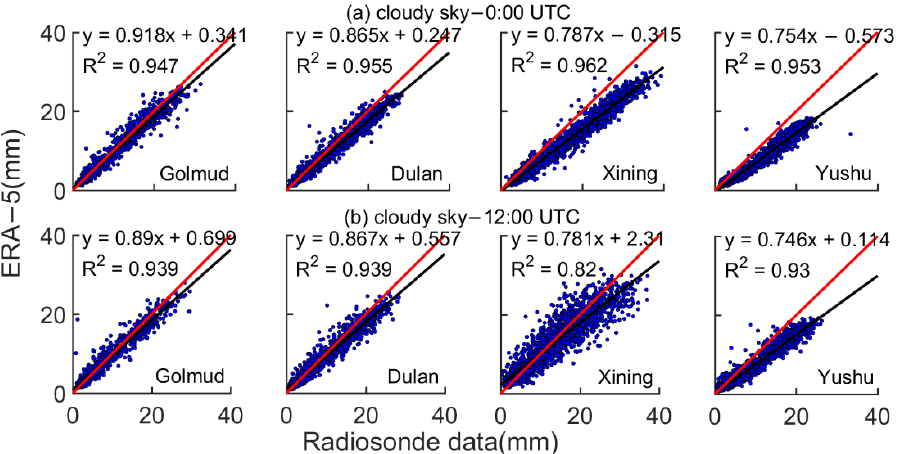
Figure A3. Scattered relationship of PWV from ERA-5 and radiosonde data under cloudy conditions at different meteor- ological stations. Black solid line is for linear fit, and red solid line is y = x. ( a ) 0:00 UTC; ( b ) 12:00 UTC.